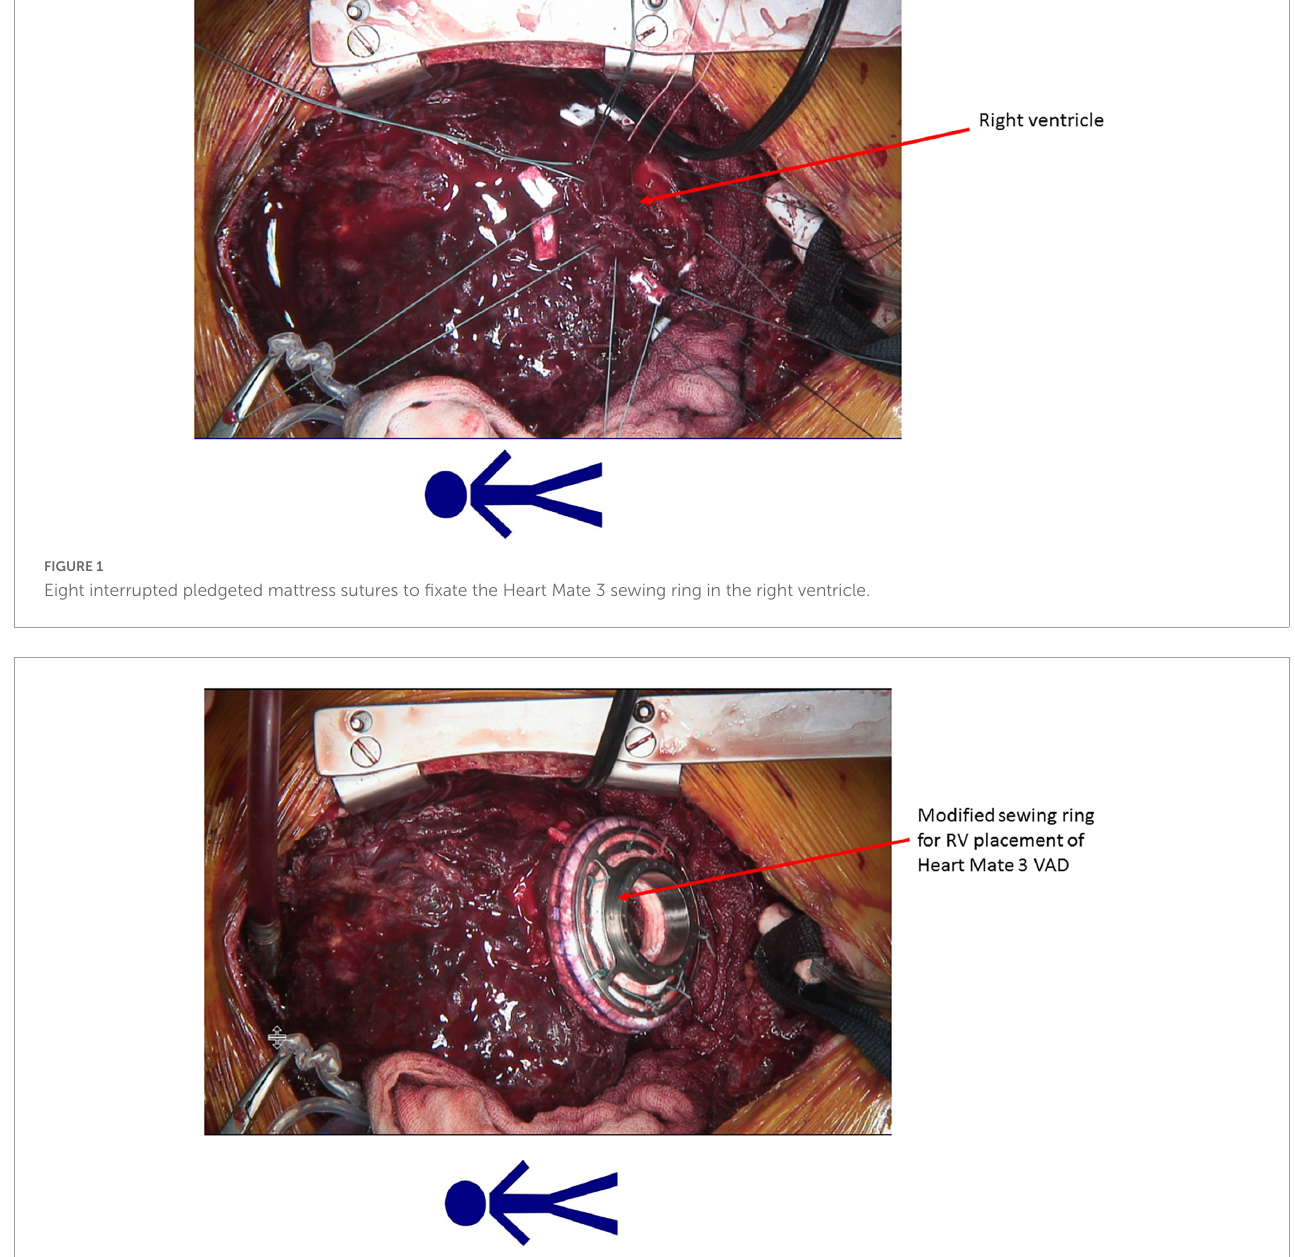
Frontiers in Cardiovascular Medicine